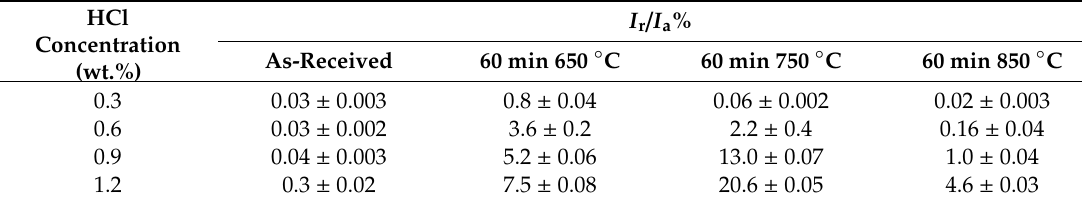
Table 3. I r / I a % ratios and standard deviations in 33 wt.% H 2 SO 4 solution with di ff erent